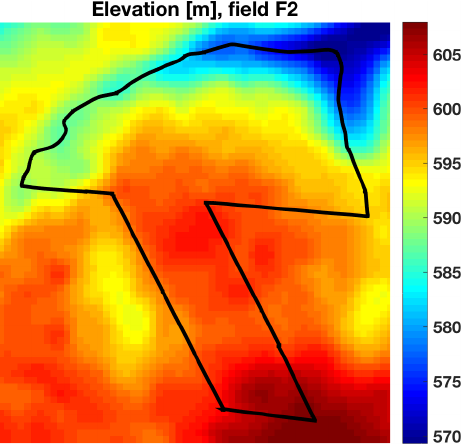
Figure 9. Elevation of Field F2. North direction is up and field spans approximately 1.4 km northward by 1.7 km